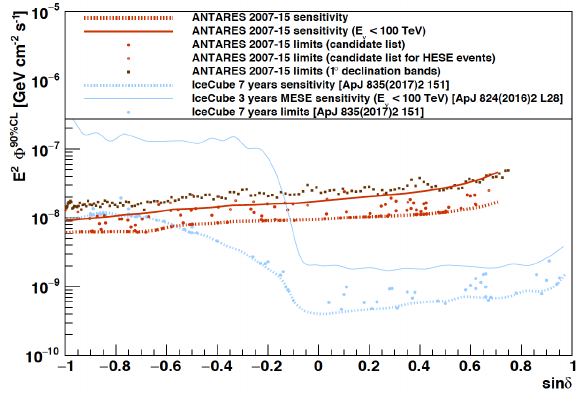
Figure 7. ANTARES 90% C.L. upper limits and sensitivi- ties [12] for the studied candidate list as function of the declina- tion for a E − 2 ν astrophysical neutrino fl ux with and without cuto ff at 100 TeV compared with IceCube equivalent results [20, 21]